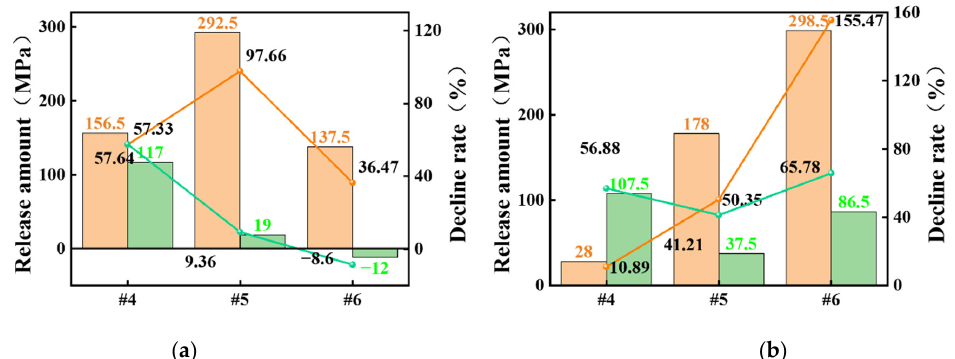
Figure 10. Change in average peak residual stress after treatment. ( a ) Front; ( b ) Back. Table 8. Peak residual stress changes on the front side of samples #4, #5, and #6. Therefore, the vibration time of sample #7 was increased as a means of continuing the discussion to verify the